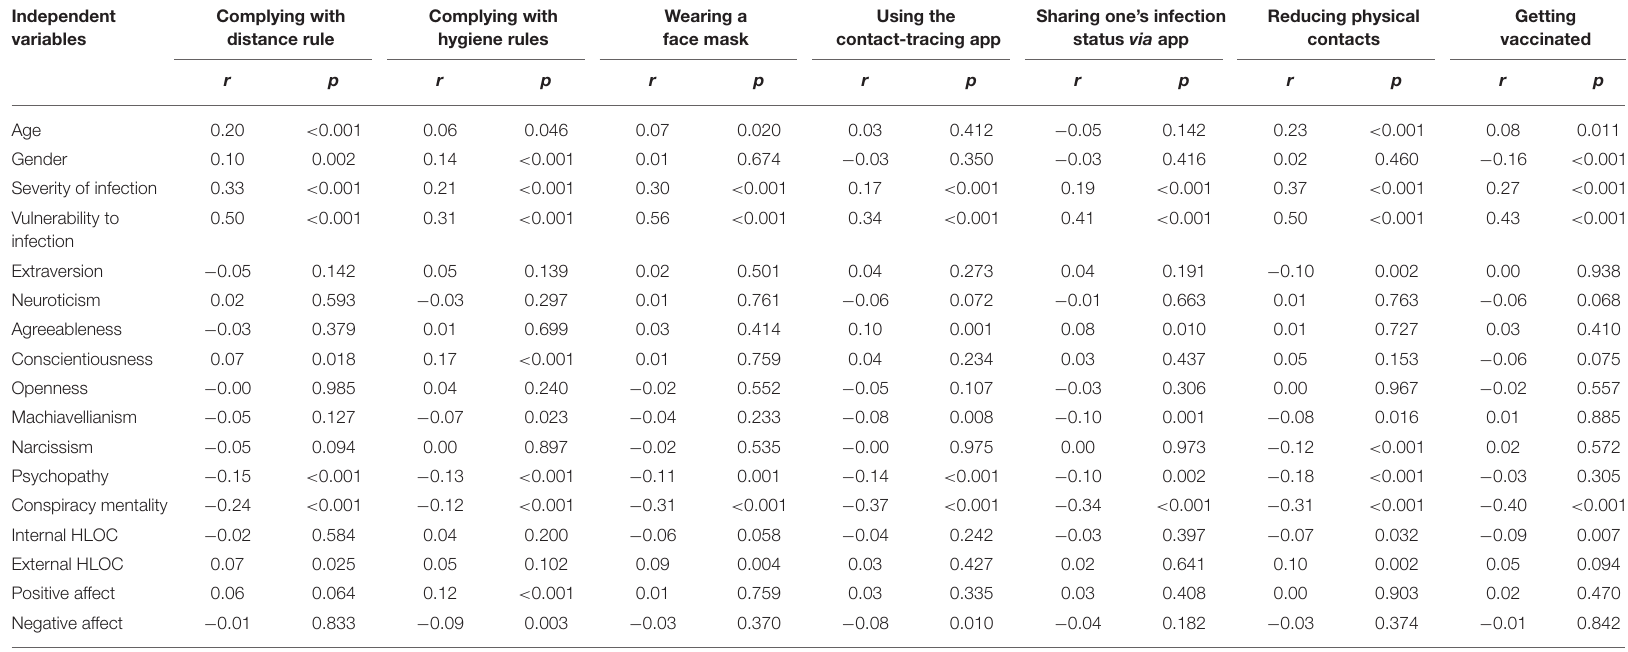
TABLE 3 | Bivariate correlations between independent and dependent variables of the regression